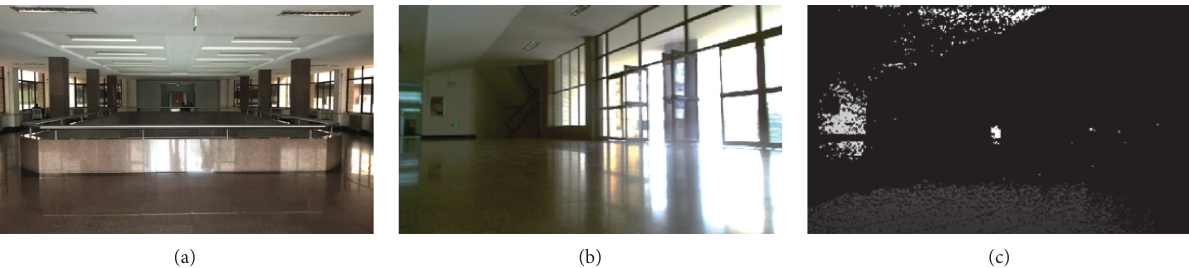
Figure 8: Second floor cloister of the main building. (a) Corridor hall on the 2nd floor. In the scene (b) with sunlight interference, depth camera (c) cannot obtain depth information.